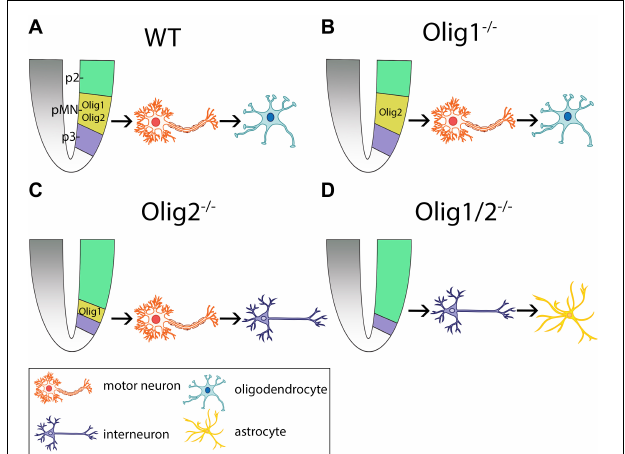
FIGURE 1 | Schematic of cellular patterning in the mammalian spinal cord after loss of Olig function. (A) Olig1 and Olig2 expression is restricted to the progenitors of motor neurons (pMN) domain in wildtype (WT) mice. Here, motor neurons are generated first followed by generation of oligodendrocytes. (B) Loss of Olig1 results in similar cellular differentiation and specification as WT mice. (C) Loss of Olig2 results in partial expansion of the p2 domain into the pMN domain. Here, motor neurons are generated prior to the generation of interneurons. (D) Loss of Olig1/2 results in complete invasion of the pMN domain by the p2 domain. Here, interneurons are generated prior to the generation of astrocytes. pMN = progenitors of motor